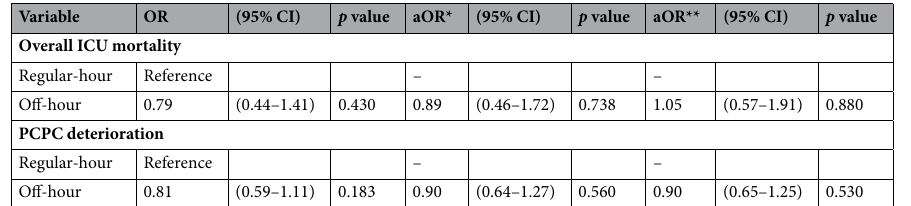
Table 3. Results of univariate logistic regression and mixed-effects model multivariate logistic regression analysis. aOR adjusted odds ratio, ICU intensive care unit, PCPC pediatric cerebral performance category, CI confidence interval. aOR* was adjusted for age, sex, and PIM2 (model 1). aOR** was adjusted for the propensity score calculated using patient background data (age, sex, PIM2 score, pre-admission PCPC, category of primary diagnosis, and source of admission) (model